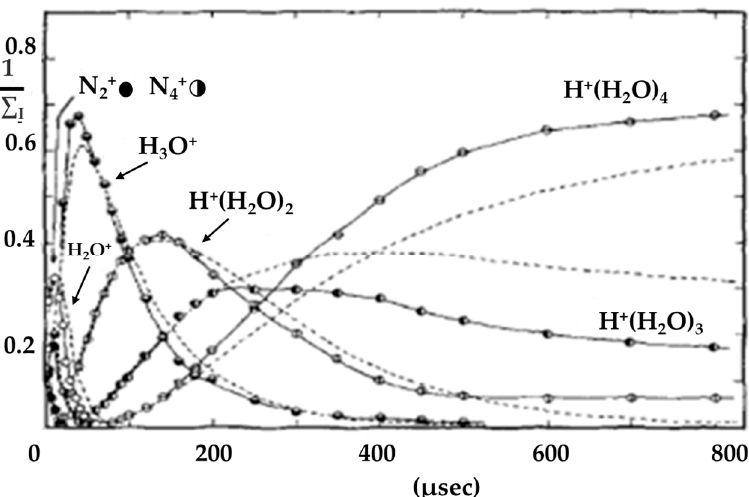
Figure 1. Normalized ion-intensity curves for ions in moist nitrogen after being subjected to a 10 µ s electron pulse. Dashed lines represent theoretical curves calculated from integrated rate equations for consecutive reactions including reversible steps using average rate constants. Figure adapted from [18] with permission. Copyright 1970 American Institute of Physics.